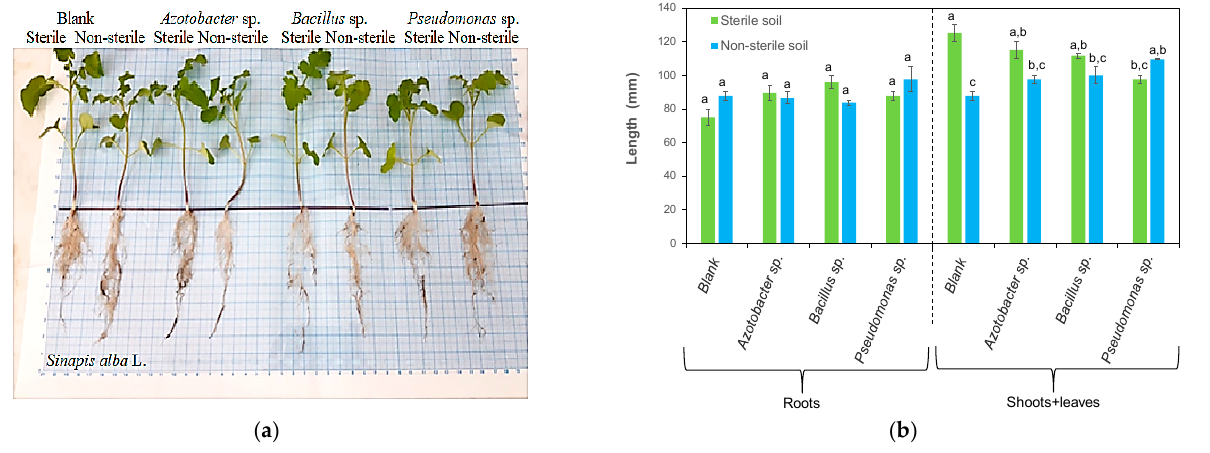
Figure 3. Effects of Azotobacter , Bacillus and Pseudomonas species on Sinapis alba L.: ( a ) visual aspect of plants and ( b ) the root and shoot/leaf length (error bars represent the experimental error; means that do not share a letter are significantly different according to the Tukey’s HSD test).